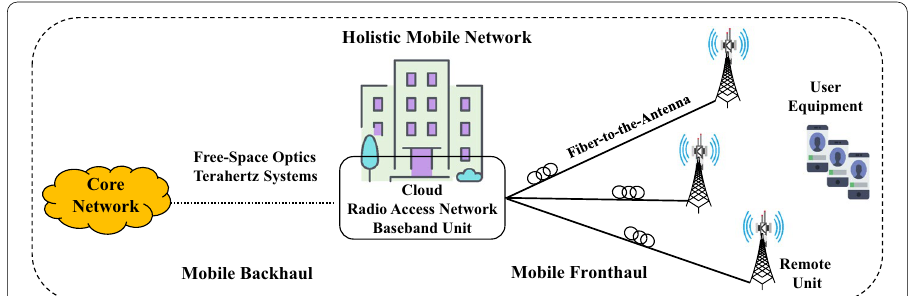
Fig. 2 Holistic mobile network including the new concept of cloud/centralized radio access